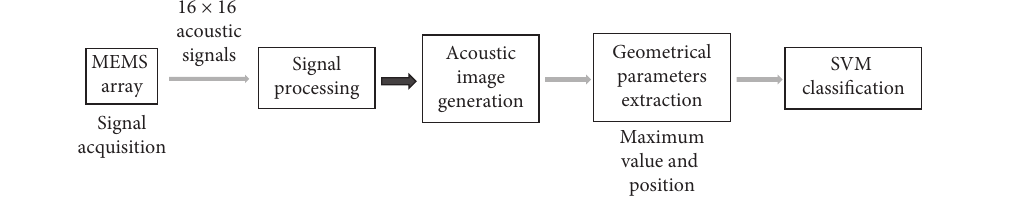
Figure 6: Block diagram of the compared methodologies.